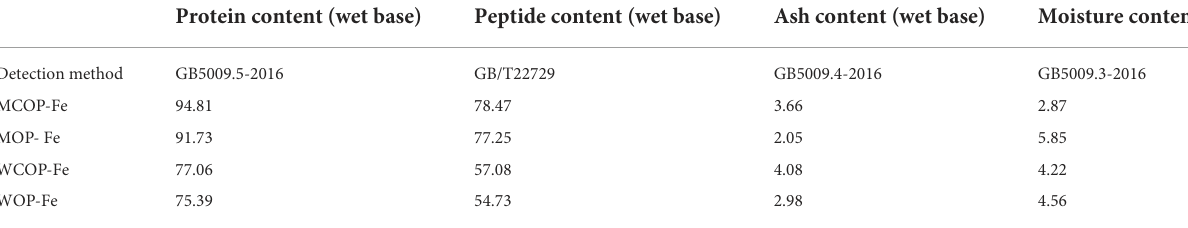
TABLE 1 Composition of food-derived bioactive oligopeptide iron complexes.